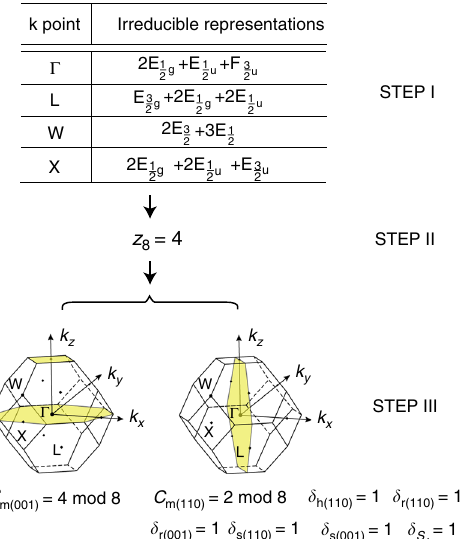
Fig. 1 A demonstration of the diagnosis for tin telluride of space group Fm (cid:1) 3 m (#225) using our results. The table on the top shows the symmetry data obtained in the fi rst-principles calculation (details given in text), where the numbers of appearance of each irrep in the valence bands are listed for each high-symmetry point in the face-centered-cubic Brillouin zone. From the data one fi nds the SI z 8 = 4 using Supplementary Tables 1 and 2, and then by searching for this indicator in Supplementary Table 7, two possible sets of topological invariants are found, listed at the bottom left and bottom right, respectively. The yellow planes in the Brillouin zone are where the mirror Chern numbers C m(001) and C m(110) are de fi ned. Indices in the parentheses in subscript represent the directions of the corresponding symmetry elements. The real material has been shown in ref. 23 to have the topological invariants listed on the bottom right